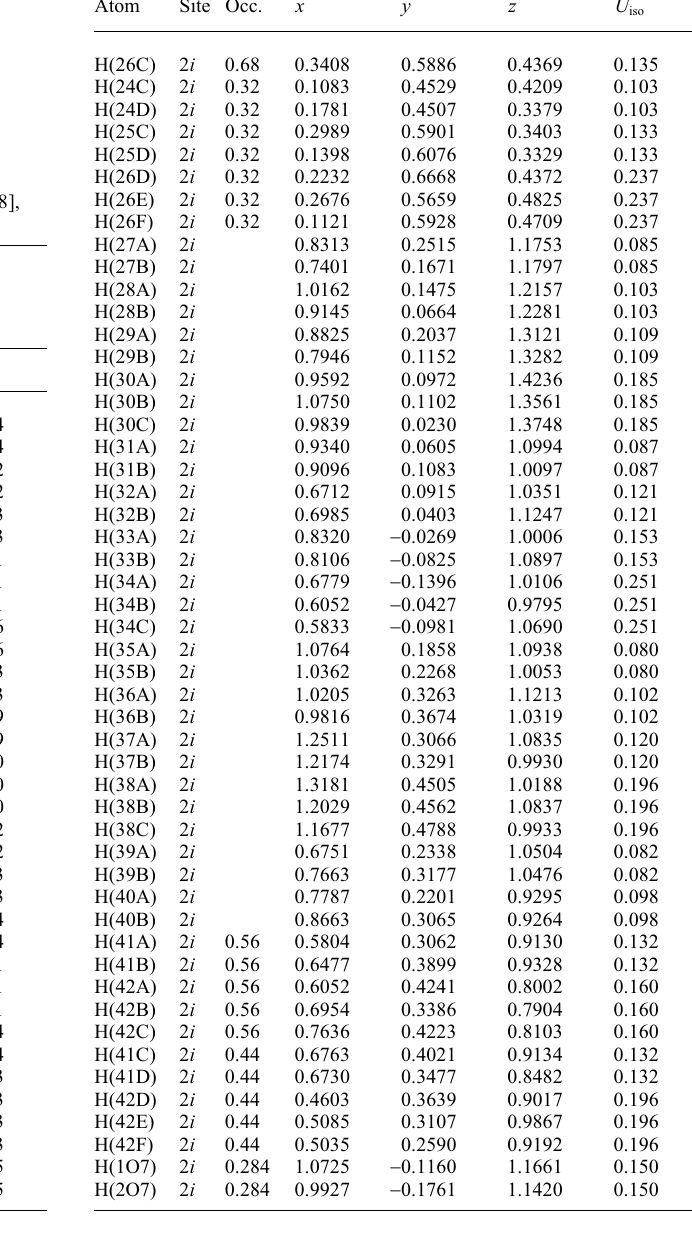
Table 3. Atomic coordinates and displacement parameters (in Å 2 ).